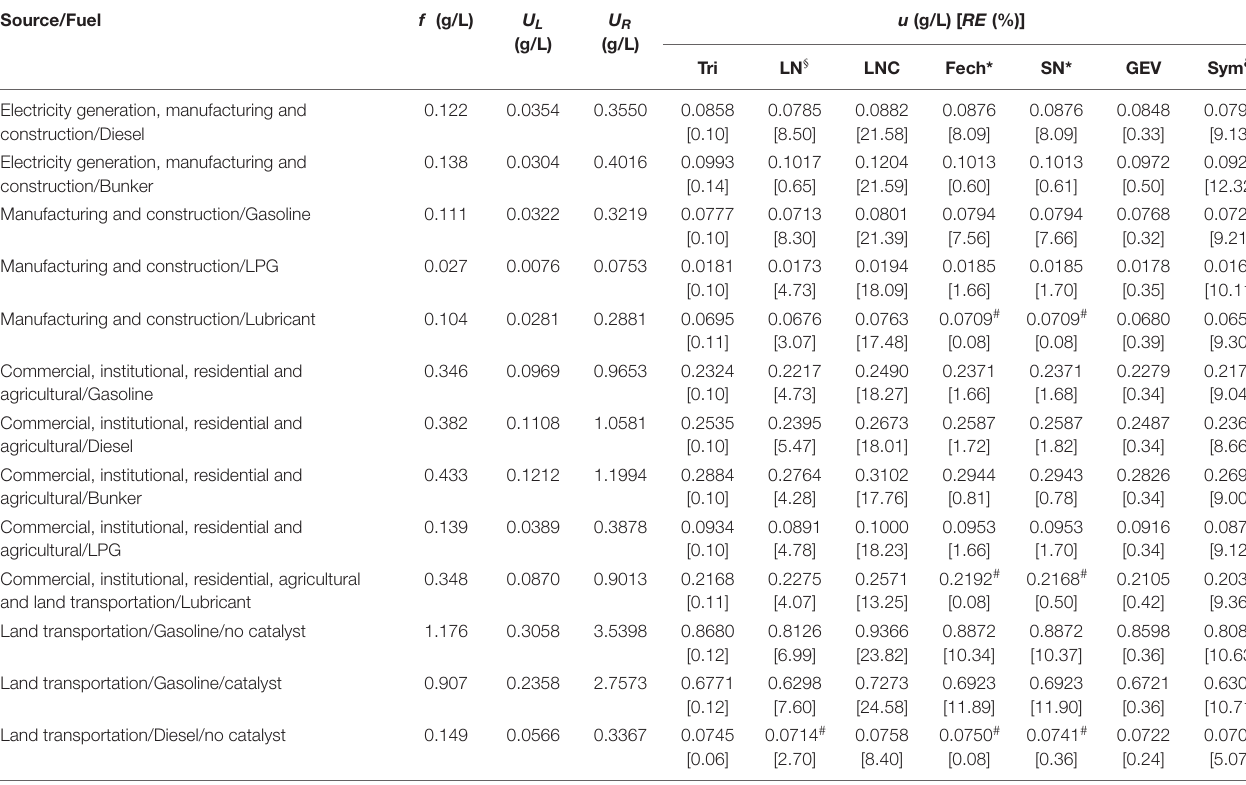
*Distribution may not be suitable according to Possolo et al. (2019). TABLE 2 | Absolute standard uncertainties u and largest relative error RE estimated for CH 4 emission factors for the fuel sector using various asymmetric approaches. The best estimate f and expanded asymmetric uncertainties U L and U R were taken from the official database of Costa Rican emission factors (IMN, 2020). Values of RE are shown inside the